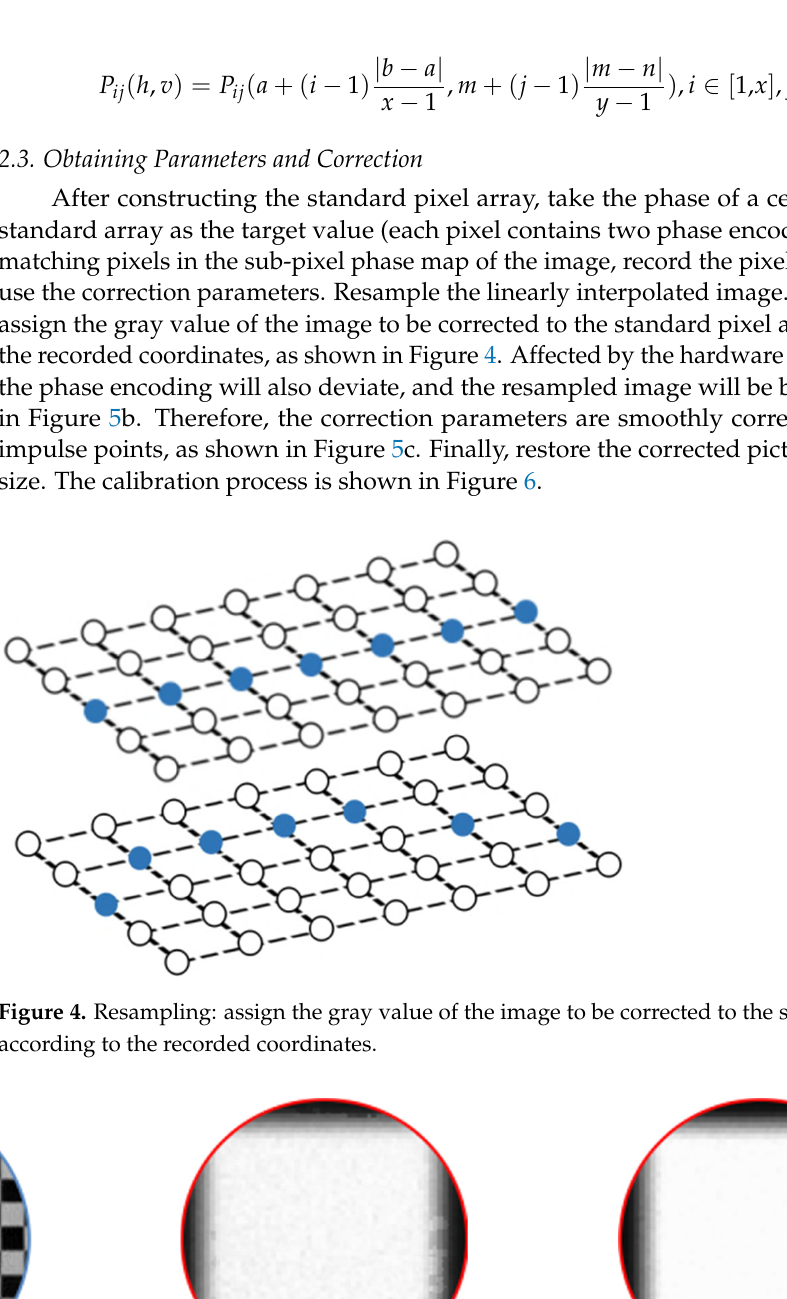
Figure 3. A schematic diagram of a standard pixel array structure.